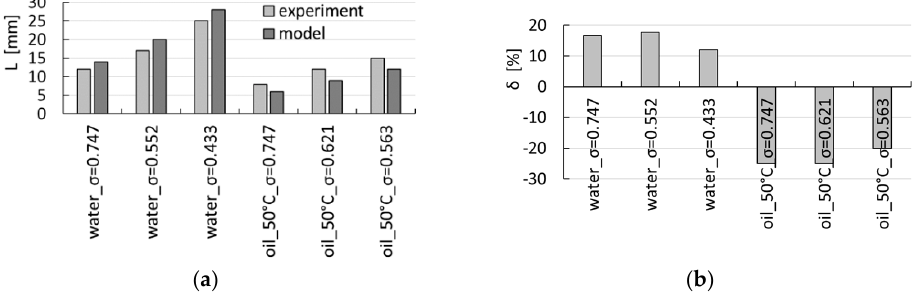
Figure 13. ( a ) Dependence of length of cavitation cloud 𝐿 from experiment and simulation for water and oil and various cavitation numbers. ( b ) Dependence of deviation δ (%) of cavitation cloud length from experiment and simulation for water and oil and various cavitation numbers.